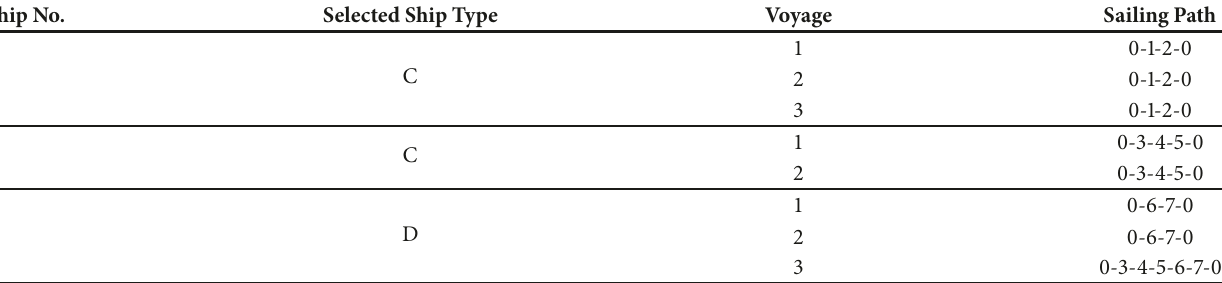
Table 5: Transportation schedule of Scheme